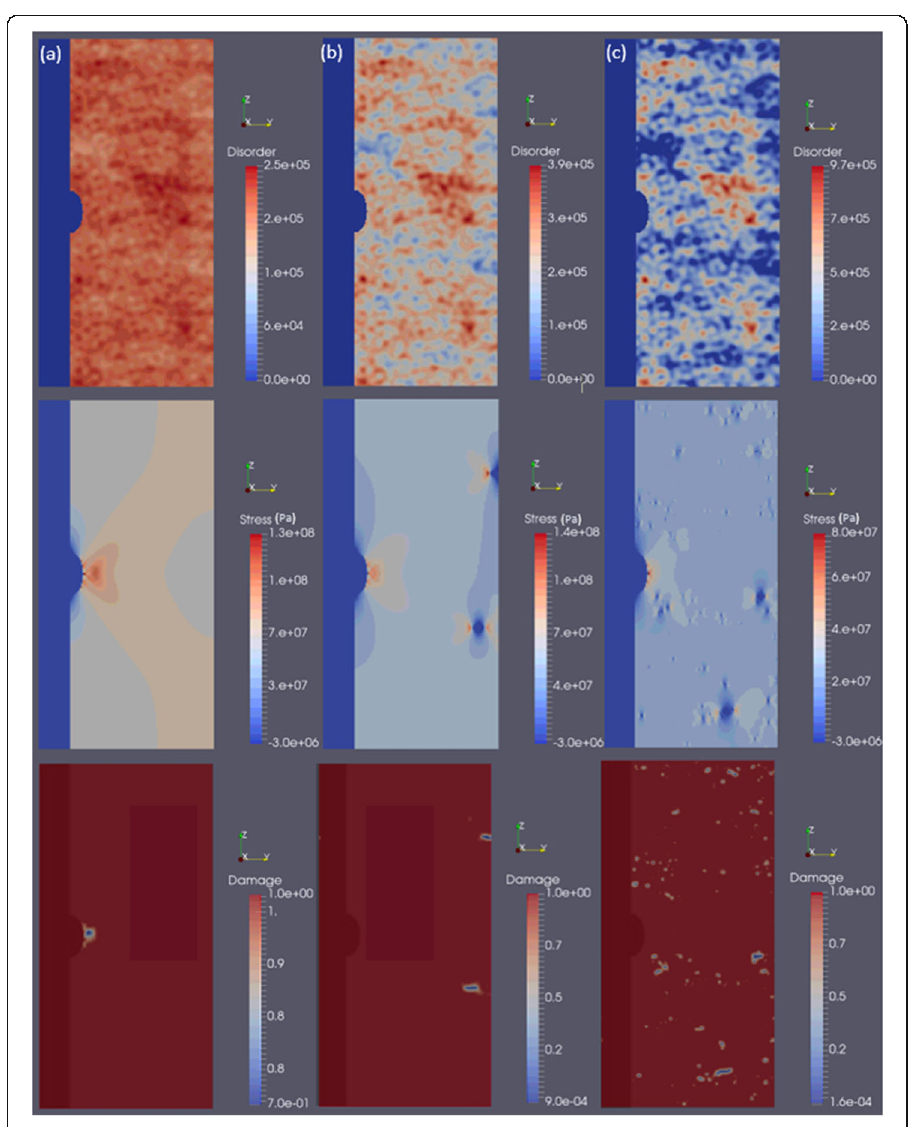
Fig. 4 Effect of increasing disorder strength on crack nucleation: Simulations of system size of L x = 8 μ m, L y = 0.5 mm, and L z = 1.0 mm where D = 2.995, W = 0.125 mm, and ( a ) has a R G of 0.05 ( b ) has a R G of 0.2 ( c ) has a R G of 0.8 where the disorder, stress and damage distributions are displayed (top, middle, bottom